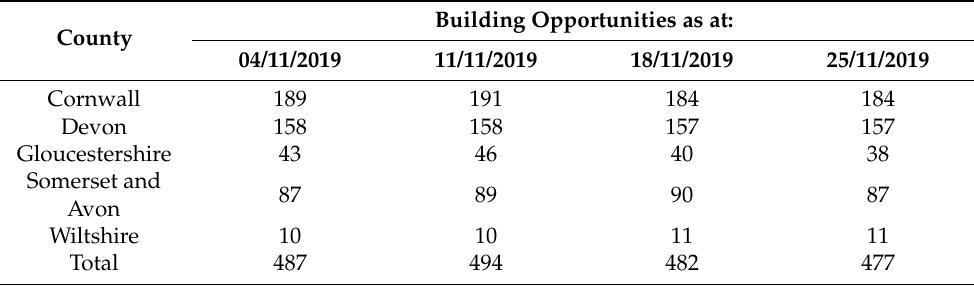
Table 12. BuildStore building opportunities advertised the study area during November